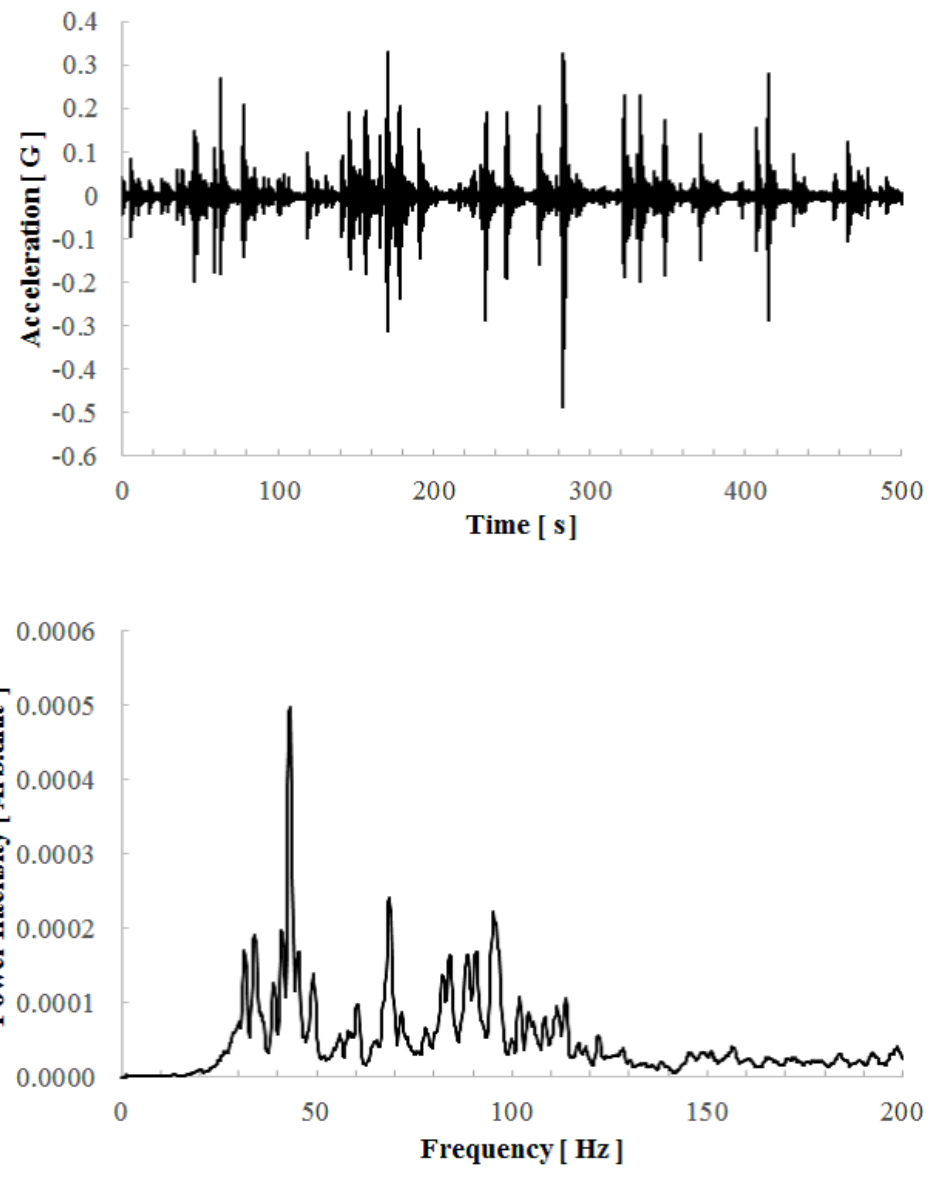
Figure 11. ( a ) Measured time-evolution acceleration wave taken on the viaduct of a highway; and ( b ) its power